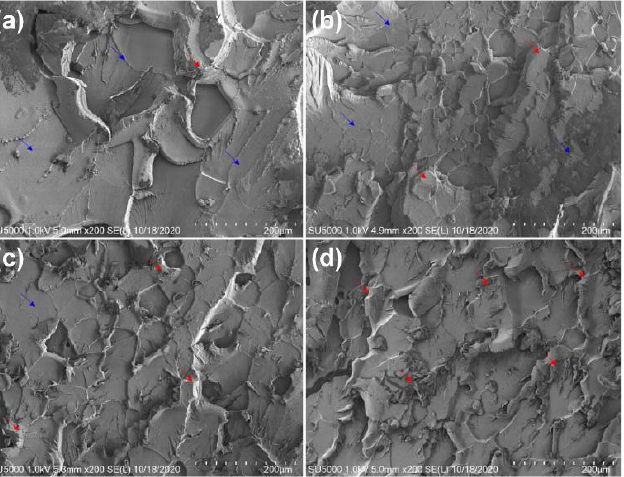
Figure 7. SEM images of ( a ) the pure epoxy resin and the 1.0 wt.% TiO 2 –epoxy nanocomposites with ( b ) bath sonication, ( c ) probe sonication, and ( d ) focused sonication.